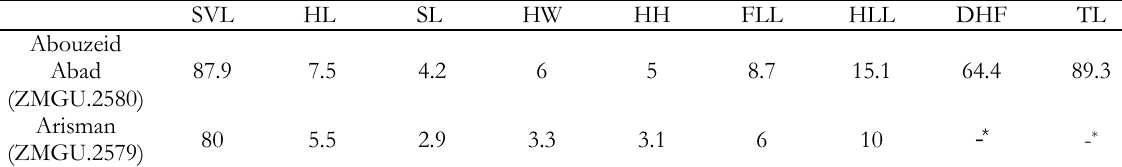
cloaca to tip of